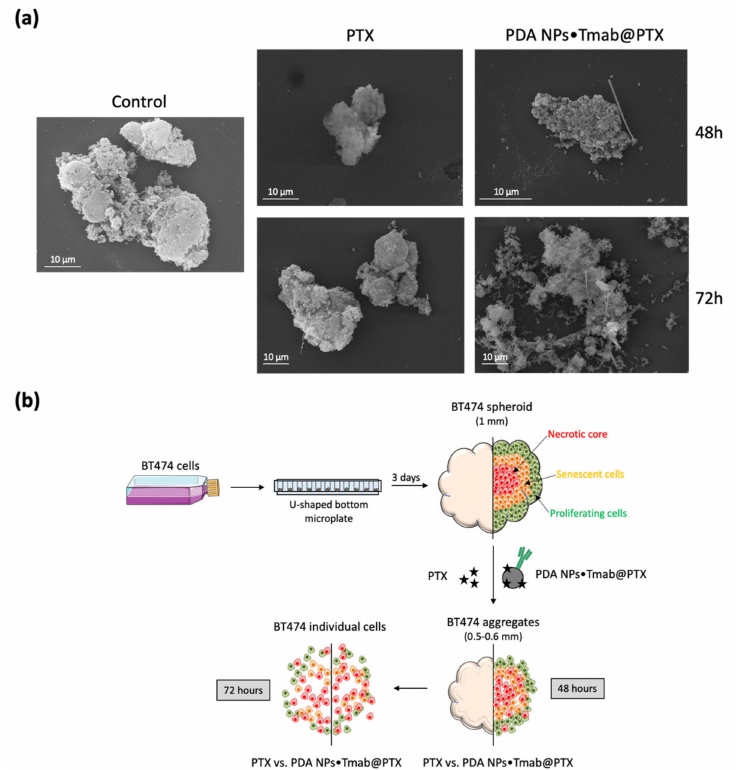
Figure 5. ( a ) SEM characterization of sections of BT474 spheroids 48 and 72 h after treatment with PTX (99.5 nM) and PDA NPs • Tmab@PTX (0.035 mg/mL); ( b ) schematic representation of how